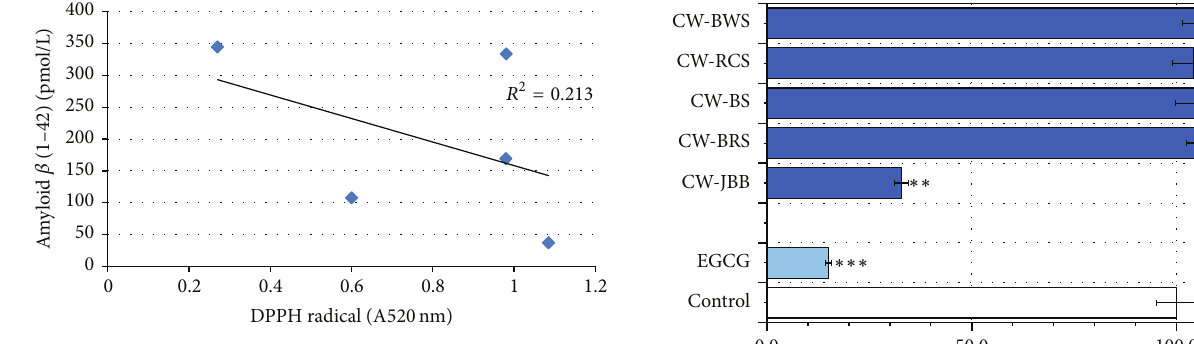
Figure 4: The correlation between levels of A 𝛽 (1–42) and DPPH radical scavenging activities of aqueous extracts from the sprouts of five plants. Figure5:ChangesinthefluorescenceofBSA+D-ribosetreatedwith